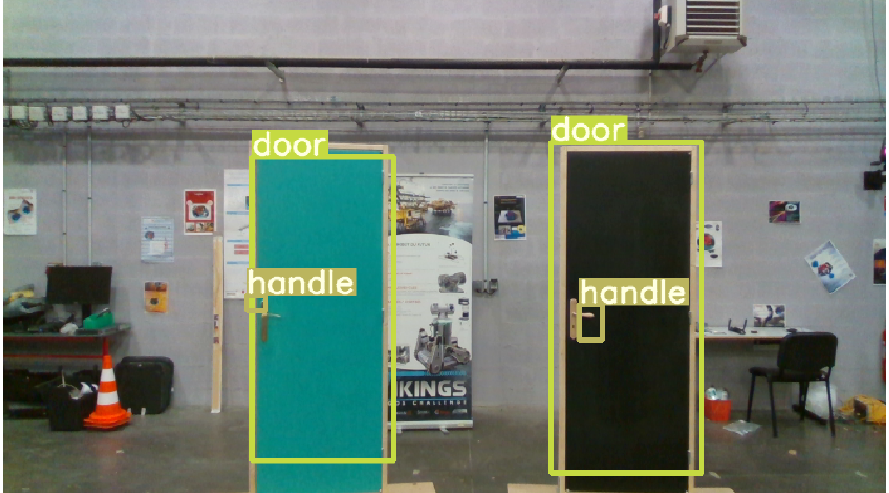
Figure 4. Example of objects detection in wheelchair indoor environment including doors and